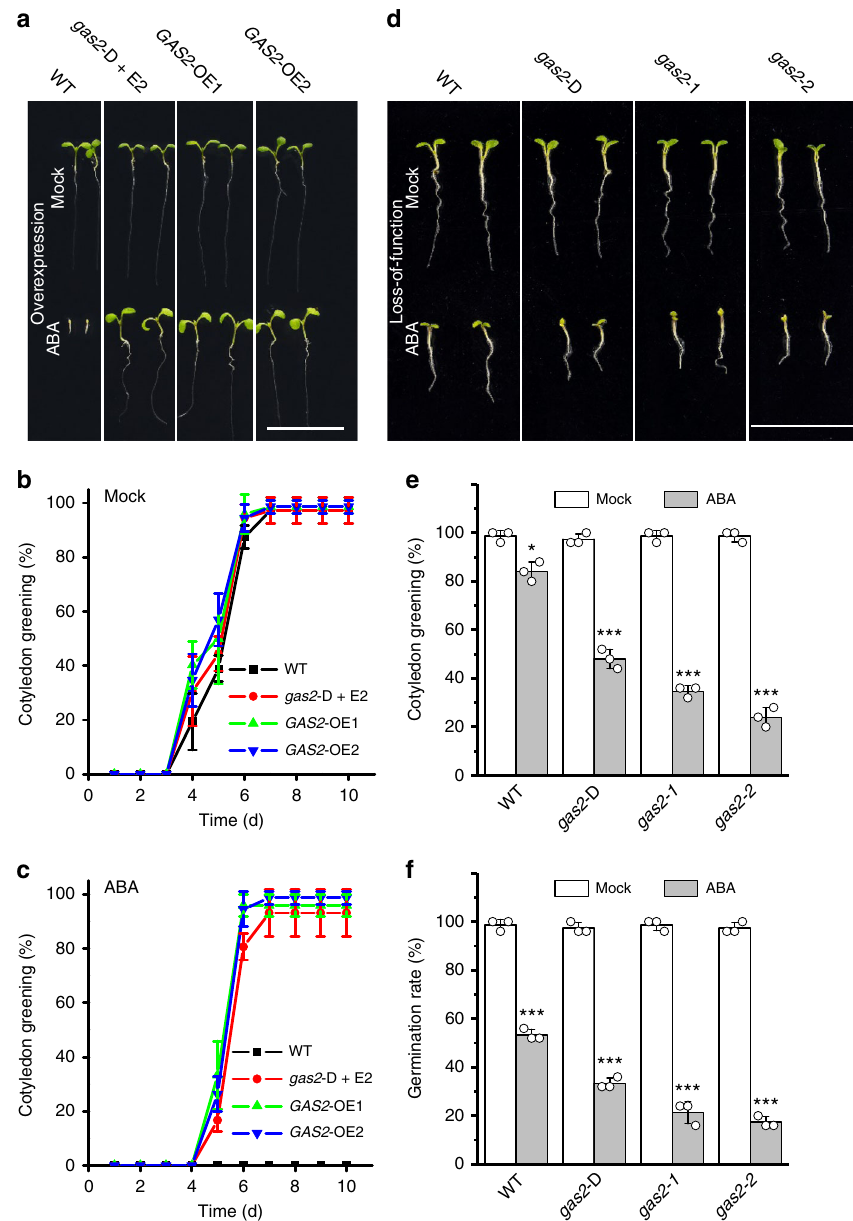
Fig. 1 GAS2 modulates the sensitivity to ABA in seed germination and seedling establishment. a Phenotypes of 10-d-old seedlings of wild-type, E2-induced gas2 -D and two GAS2 overexpression transgenic lines ( GAS2 -OE1 and OE2), grown on MS in absence (Mock) or presence of 0.5 µ M ABA (ABA). Bar = 1.5 cm. b , c Cotyledon greening analysis of 10-d-old seedlings of wild-type, E2-induced gas2 -D and two GAS2 overexpression lines ( GAS2 -OE1 and OE2) grown on MS with or without the addition of 0.5 µ M ABA. Error bars represent SD (standard deviations) ( n = 72). d Phenotypes of 8-d-old seedlings of wild-type, noninduced gas2 -D, gas2-1 and gas2-2 , grown on MS in absence (Mock) or presence of 0.2 µ M ABA (ABA). Bar = 1.5 cm. e Cotyledon greening analysis of 8-d-old seedlings of wild-type, noninduced gas2 -D, gas2-1 and gas2-2 grown on MS in absence (Mock) or presence of 0.2 µ M ABA (ABA). Error bars represent SD (standard deviations) ( n = 72). f Seed germination analysis of wild-type, noninduced gas2 -D, gas2-1 and gas2-2 , grown on MS in absence (Mock) or presence of 0.2 µ M ABA (ABA) at 48 h. Error bars represent SD (standard deviations) ( n = 72). E2 stands for 17- β -estradiol. * P < 0.05, *** P < 0.001, t test versus mock ( e and f ). Source data are provided as a Source Data fi le. ABA abscisic acid, MS Murashige and Skoog